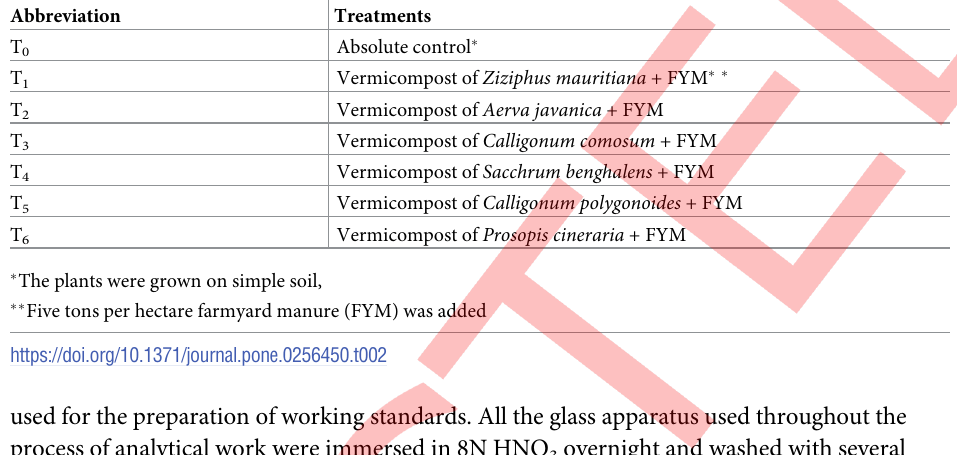
Table 2. Experimental treatments used in the study, their abbreviations and explanations.